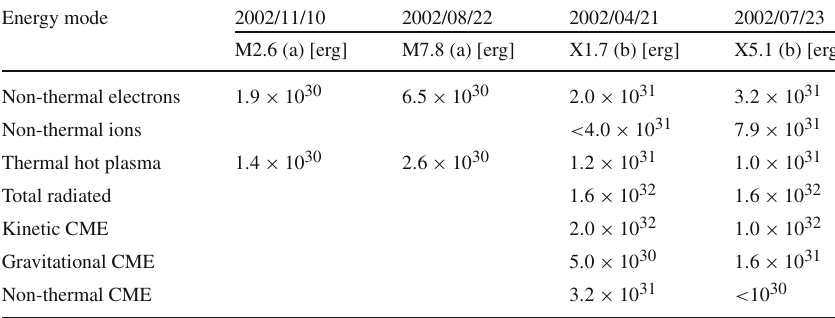
Table 1 Energy budgets as reported by Saint-Hilaire and Benz (2005) for two M-class flares (a) and by Emslie et al. (2005) for two X-class flares